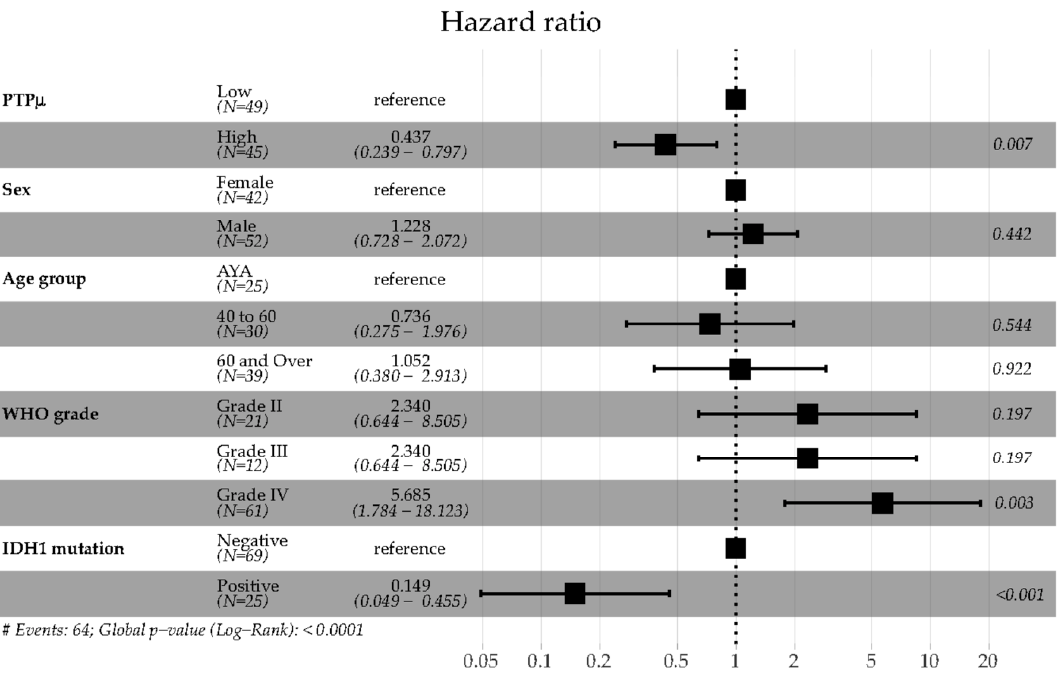
Figure 3. Forest plot of hazard ratios (with 95% CIs) from the final multivariable Cox proportional hazards regression model for overall survival for all glioma patients. Wald test p -values are shown.